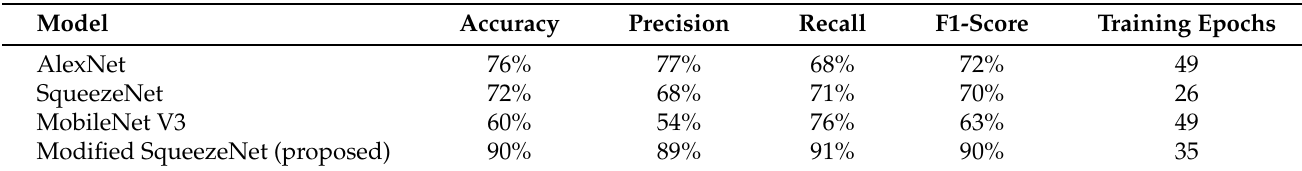
Table 5. Comparison of obtained performance metrics.